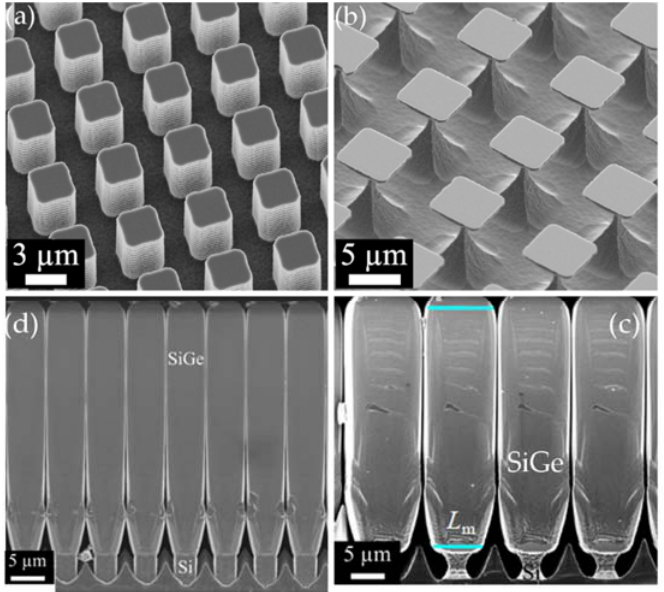
Figure 10. Growth on vertical and under-etched pillars. From Ref. [45]: SEM images of vertical ( a ) and under-etched ( b ) Si pillars. Cross-sectional SEM images of SiGe crystals grown on under-etched ( c ) and vertical ( d ) pillars. Reproduced with permission from [46]. American Physical Society.